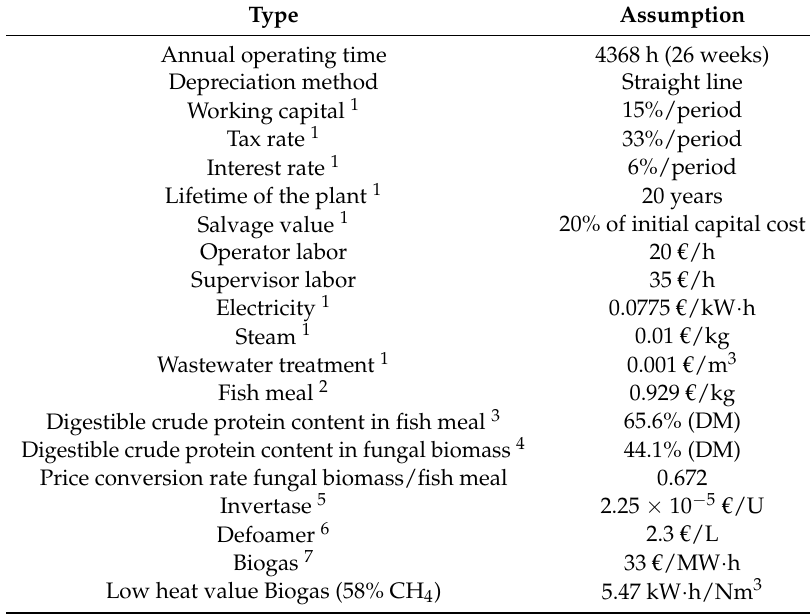
Table 3. Economic evaluation inputs and operational